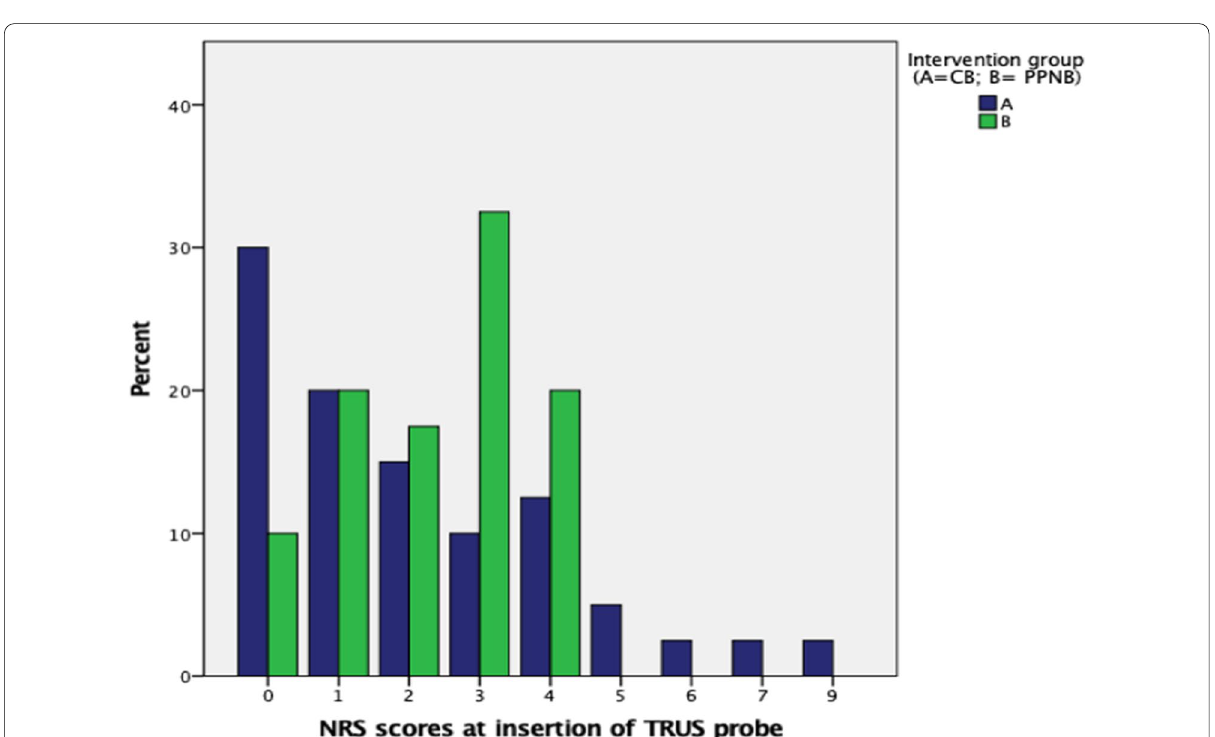
Fig. 2 Bar chart showing the percentages of men per reported NRS pain score for each intervention group at the insertion of the TRUS probe. CB (Group A); PPNB (Group